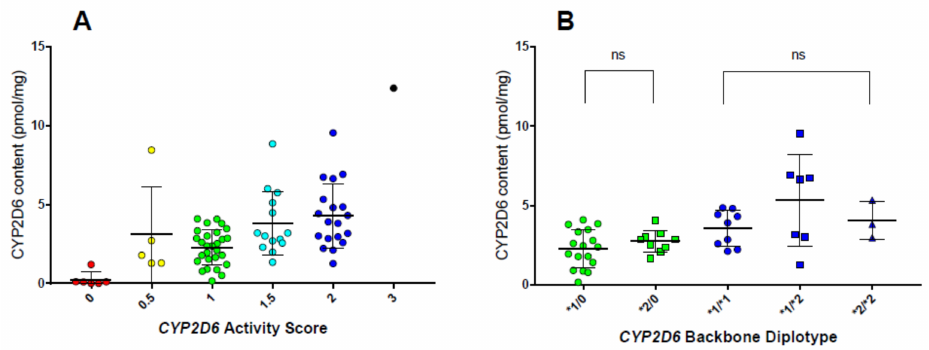
Figure 2. ( A ) CYP2D6 protein content (pmol/mg microsomal protein) stratified by CYP2D6 activity score (AS) in pediatric human liver microsomes (HLMs) ( n = 78, ages 2–18 years). A statistically significant linear trend was observed with increasing protein content corresponding with increasing CYP2D6 AS. One-way ANOVA analysis identified only significant differences between HLMs of AS = 0 and HLMs with scores greater than 0; ( B ) a subset of pediatric HLMs ( n = 45) were used to analyze CYP2D6 protein content as a function of activity score (green symbols, AS = 1; blue symbols, AS = 2) and backbone diplotype (allelic variants containing a *1 or *2 structure). A haplotype with an AS = 0 indicates the presence of two CYP2D6 allelic variant with no functional activity. No statistically significant changes in protein content were observed as a result of differing activity score or backbone